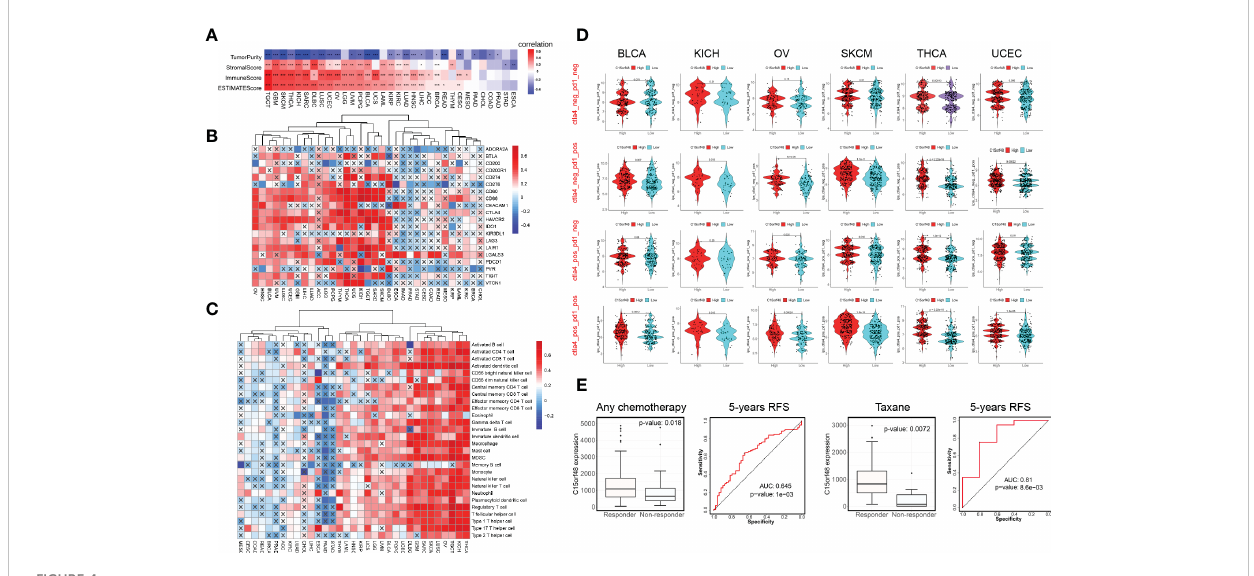
FIGURE 4 (A) Correlation between C15orf48 and tumor purity, stromal, immune, and ESTIMATE scores in pan-cancer; (B) Correlation between C15orf48 and immune checkpoints in pan-cancer; (C) Correlation between C15orf48 and immune cell in fi ltration in pan-cancer (ssGSEA); (D) Correlation between C15orf48 and immunotherapy response in pan-cancer; (E) Box plots show the C15orf48 expression differences between responders and non- responders, and ROC presents the predictive accuracy of patient therapeutic response by C15orf48 levels on the ROCplotter online website. *P < 0.05; **P < 0.01; ***P <